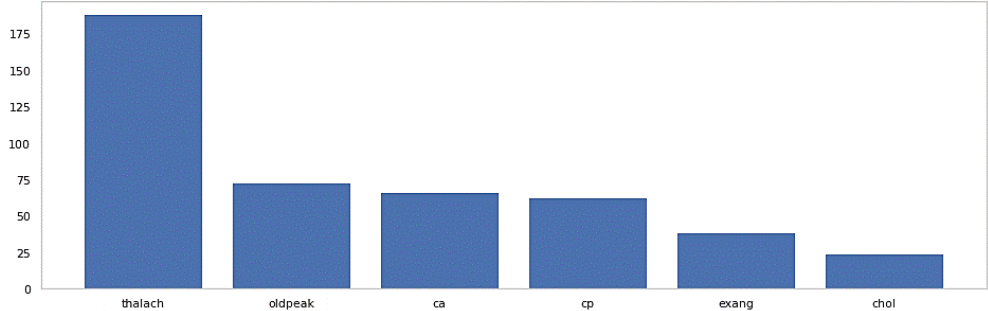
Figure 5. Selected features by highest χ 2 score (Cleveland dataset).